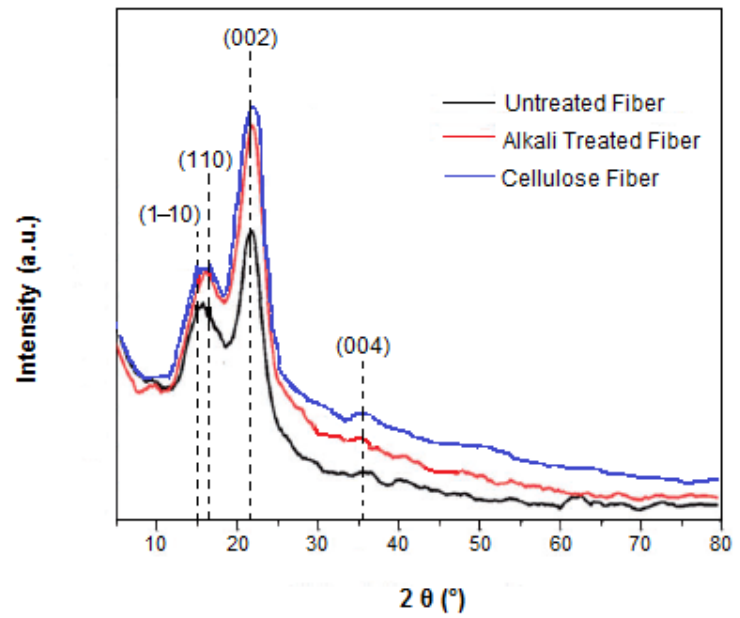
Figure 3. X-ray diffractograms of untreated, alkali-treated and cellulose fibers. The general profile of the three diffractograms is similar. The 2 θ values ranging between 10 ◦ and 40 ◦ display same main peaks at 15.0 ◦ , 16.20 ◦ , 21.85 ◦ and 35.4 ◦ . These 2 θ values were ascribed to the following crystallographic planes: (1–10), (110), (002) and (004), corresponding to the typical structure of cellulose I, conferring the material rigid nature. The existence of other fractions such as lignin, hemicellulose, amorphous cellulose and pectin in the fibers was confirmed by the presence of diffraction peaks at 2 θ values of 16.2 ◦ , while the content of α -cellulose was assigned by the peak at 2 θ values of 21.85 ◦ [52]. In general, the direction and alignment of the fibers are signed by the peak 2 θ located at 35.4 ◦ [53]. Since they contain diffraction peaks characteristic for the amorphous phase (16.2 ◦ ), as well as diffraction peaks unique for the crystalline phase (15 ◦ , 21.85 ◦ and 35.4 ◦